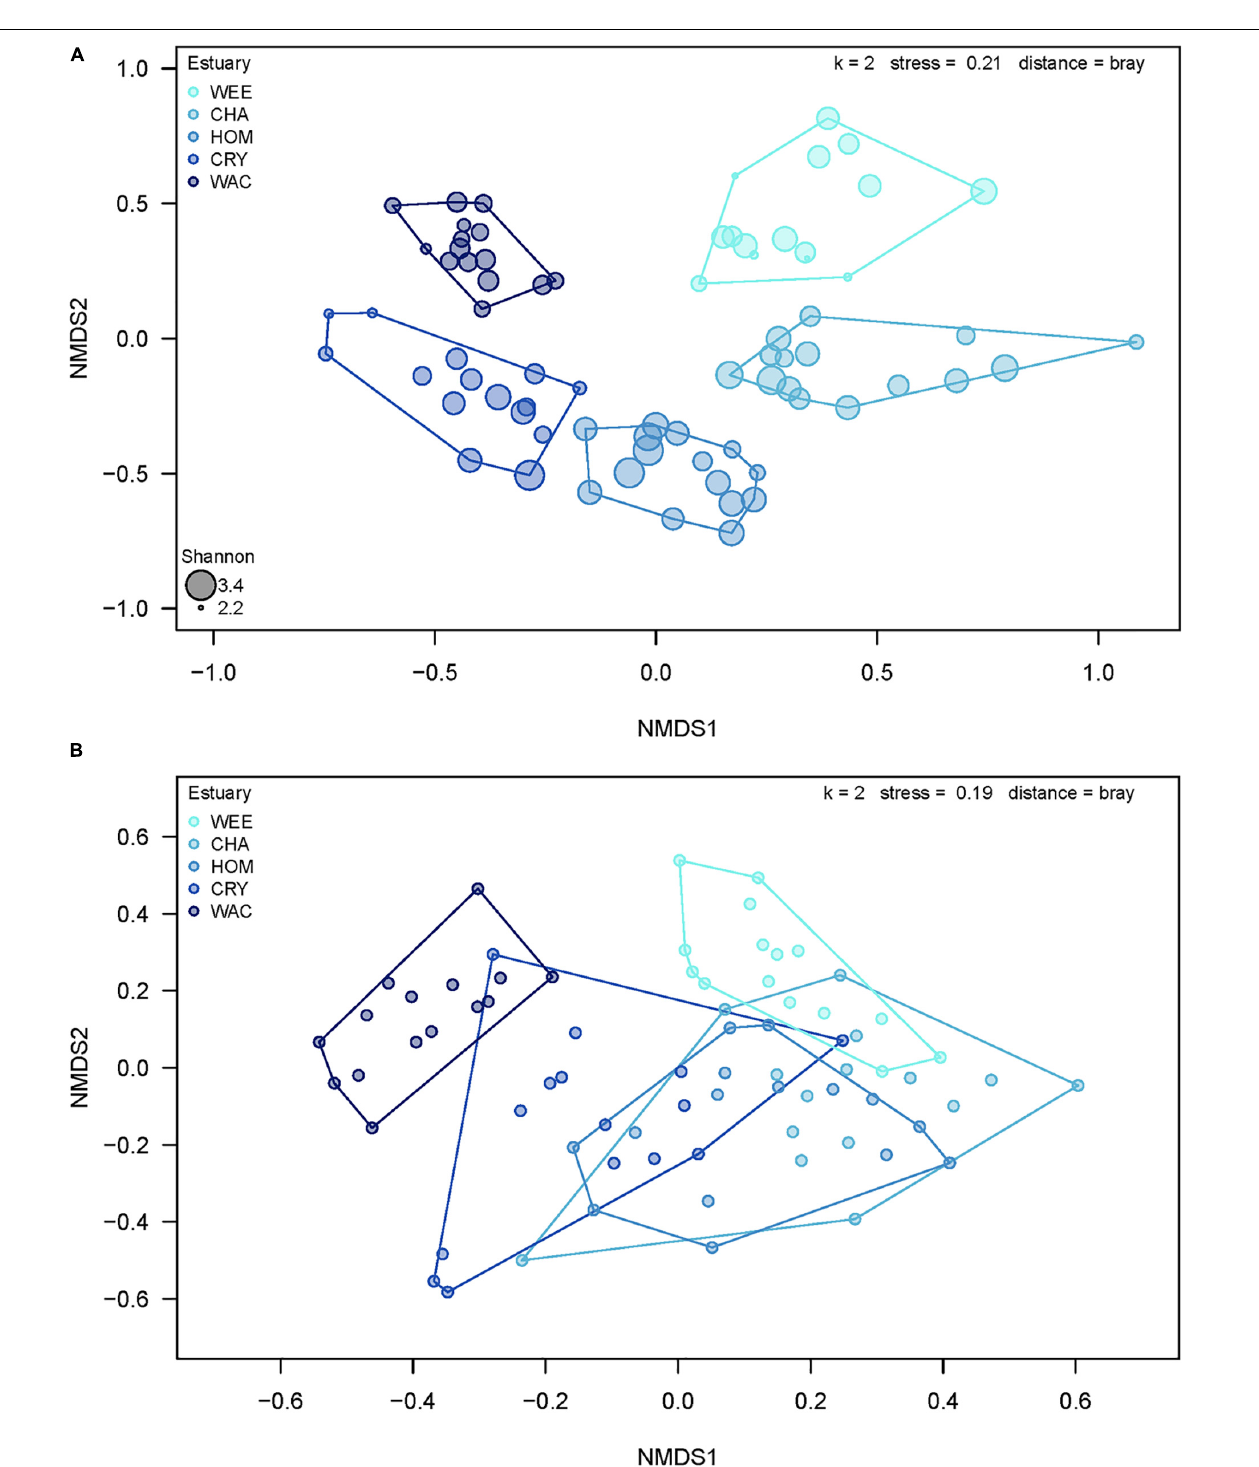
FIGURE 5 | Plot of two-dimensional non-metric multidimensional scaling based on taxonomic data summarized (A) at the species level and (B) by trophic role. WEE, Weeki Wachee; CHA, Chassahowitzka; HOM, Homosassa; CRY, Crystal River; WAC, Waccasassa. Colors indicate relative levels of long-term total phosphorus (TP) concentrations in the water column, with lighter colors indicating lower TP. Sizes of points in (A) represent the Shannon–Weaver diversity of samples, with larger sizes indicating a higher diversity value.